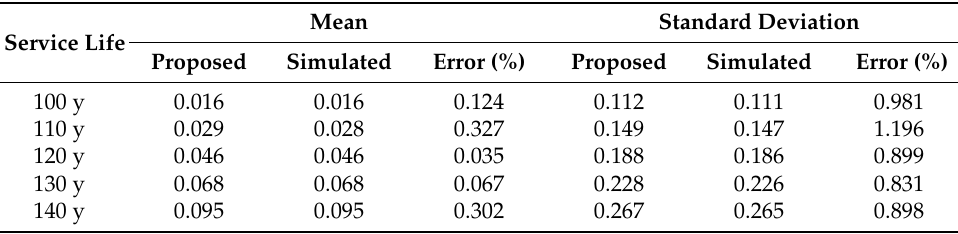
Table 3. Statistics of A sf ( t ) by the proposed and simulation-based methods ( µ ( x 0 ) = 90 mm).